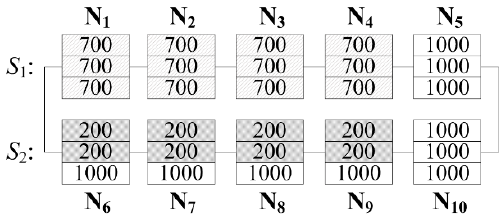
Figure 8. Irradiance pattern of Case 1.